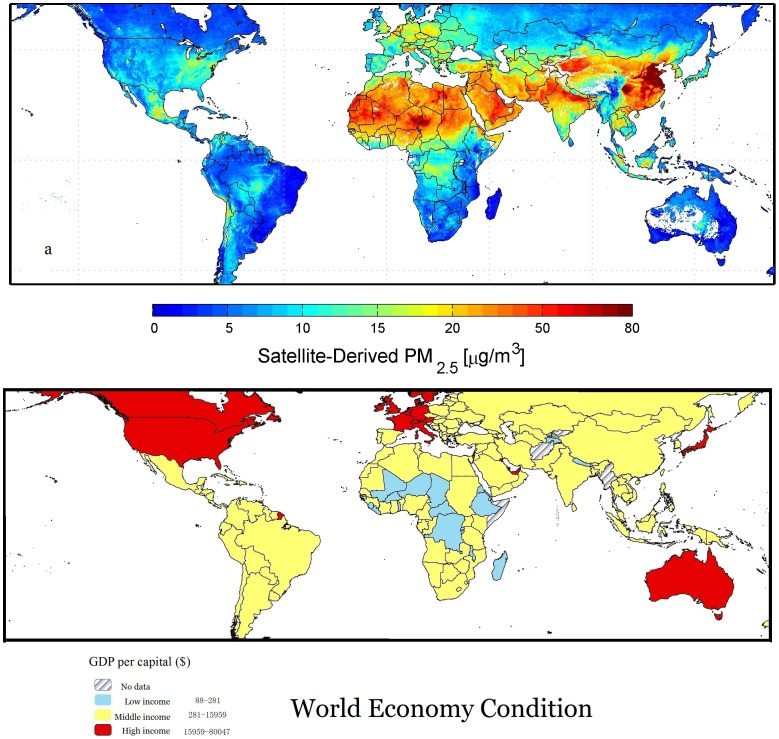
Maps of world PM2.5 (µg m−3) and GRP per capita ($) during 2001 to 2006.(a) PM2.5, downloaded from NASA website and reproduced with permission from its authors and publisher (van Donkelaar et al., 2010); (b) GRP per capital, derived from the World Development Indicators of the World Bank (http://data.worldbank.org/country).